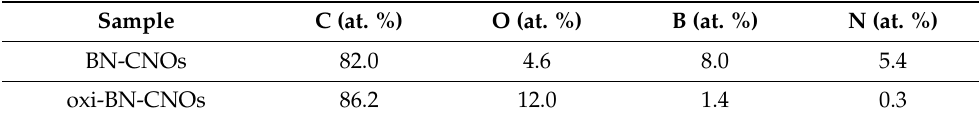
Table 1. Elemental compositions of BN- and oxi-BN-CNOs from XPS analyses. Sample